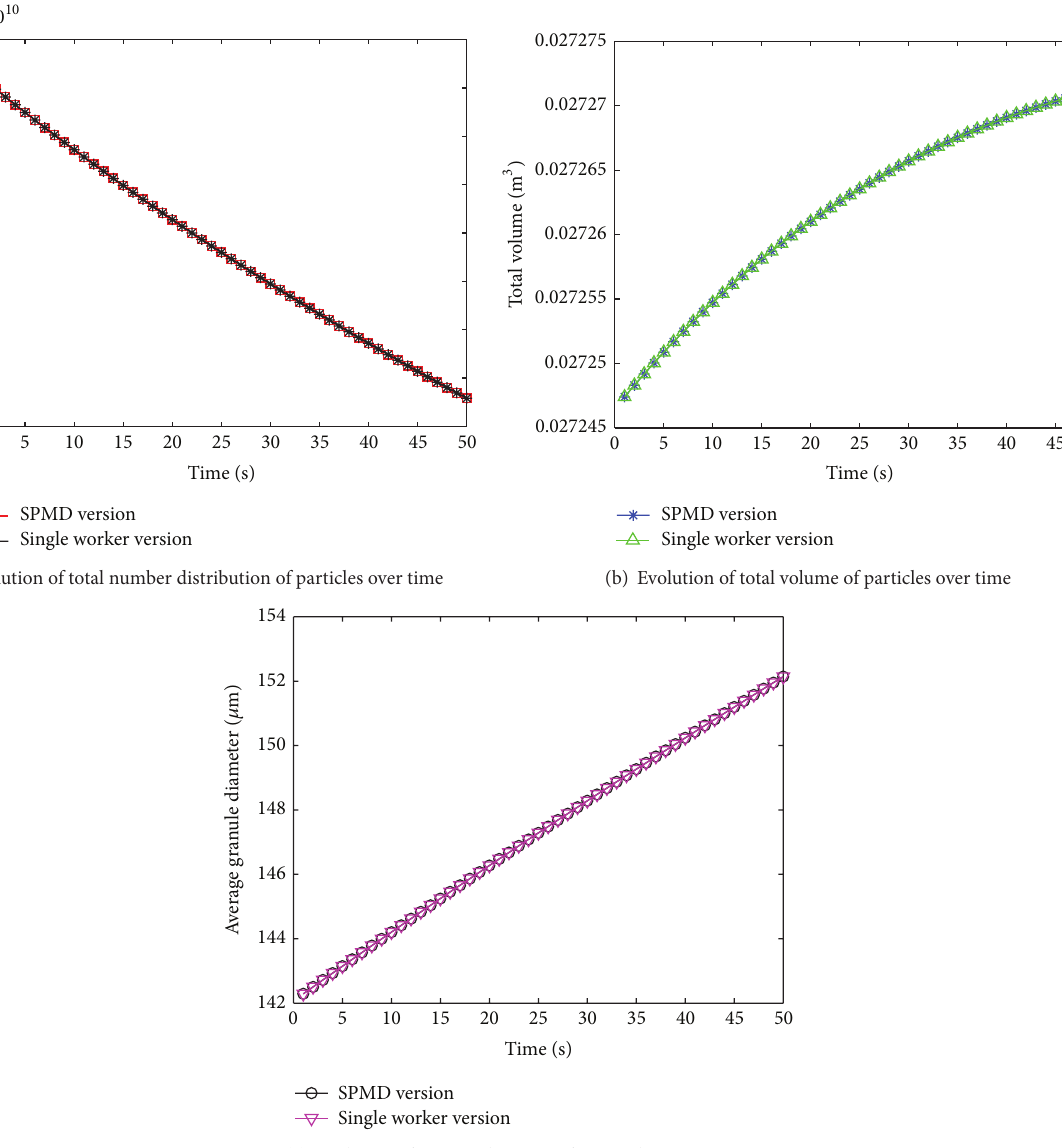
multiprocessing architecture like the INTEL Core i7 [60]; and memory conflicts between operating system services